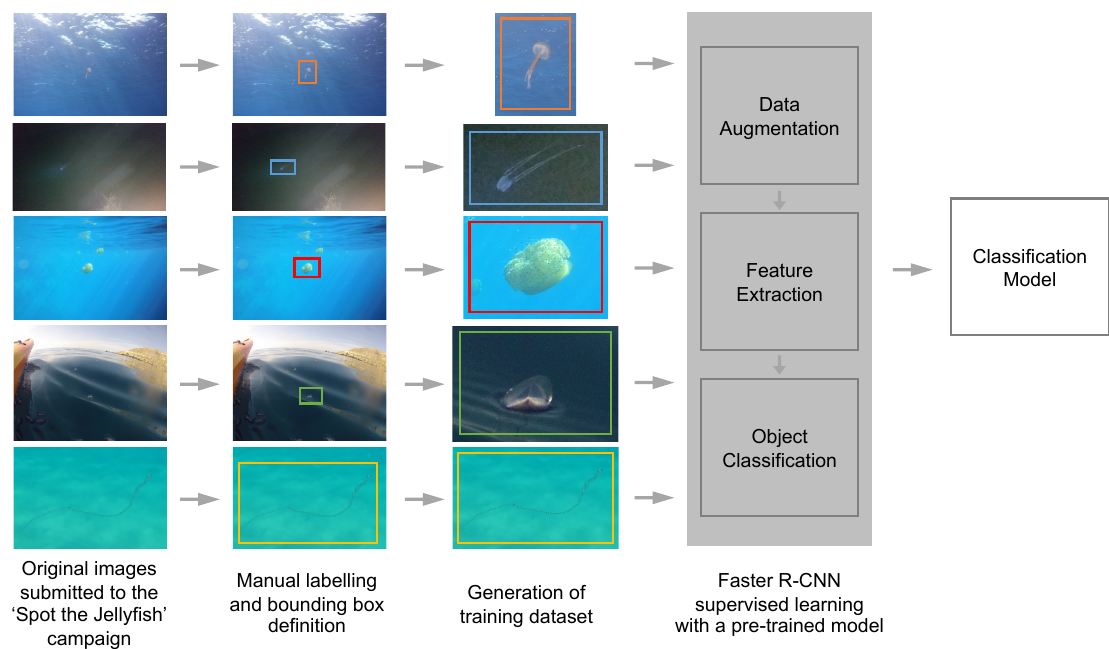
Figure 3. Adopted framework for the training of each